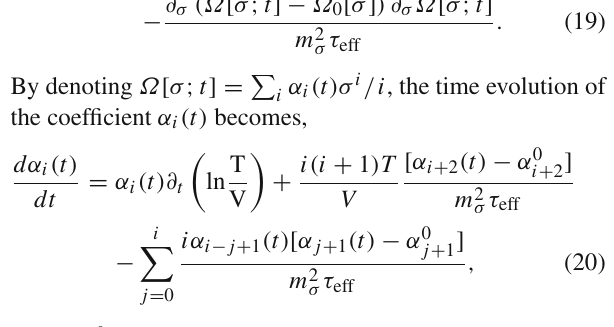
Fig. 4 Thenon-equilibriumcumulantswithrespecttothetemperature, for different relaxation rates. Here μ = 250 MeV and V = 10 3 fm 3